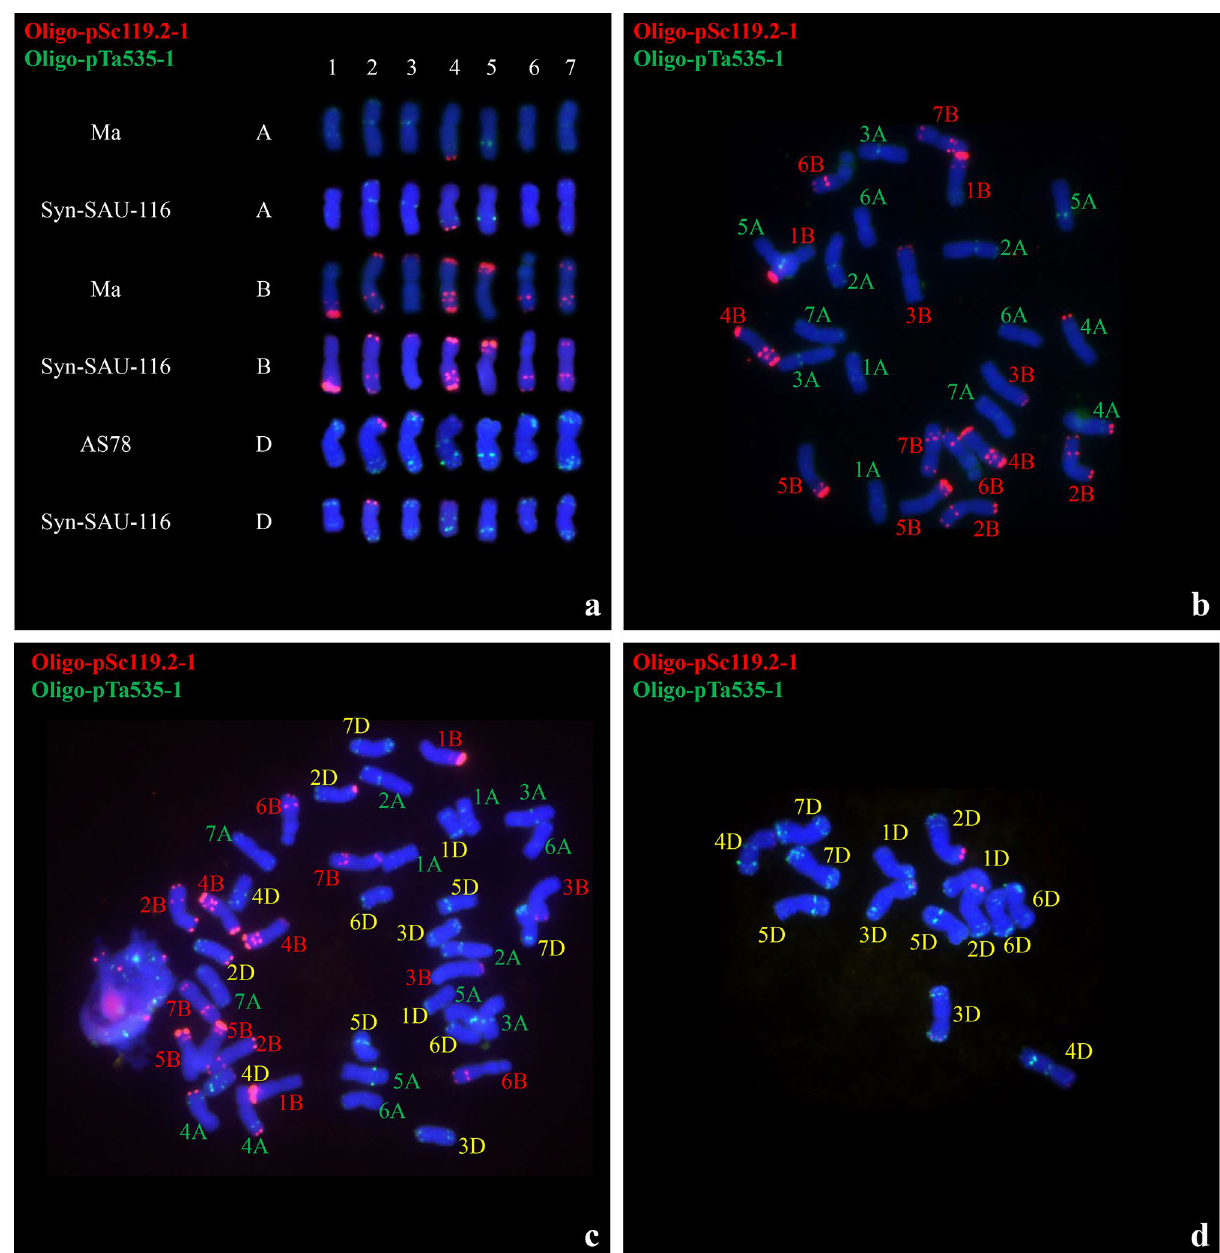
Figure 7. FISH identification of Syn-SAU-116 and its parent. ( a ): FISH karyotypes of the A, B, and D genomes in Syn-SAU-116 and its parents; ( b ): Ma; ( c ): Syn-SAU-116; ( d ): durum and Ae. tauschii , which is different from solid-stem wheat such as Xiaoyan 81, 86–741, XSXS, WYSG, etc. 12,13,53,54 . In this study, the expression of a solid second internode at the base of the stem was stable for two synthetic hexaploid wheat lines, Syn-SAU-117 and Syn-SAU-119, grown in both the greenhouse and field. The second internode at the base of the stem of Syn-SAU-117 was semisolid, while that of Syn-SAU-119 was solid in both the greenhouse and field. This difference may have been caused by the different male parents, which were all Ae. tauschii . There may be suppressor genes on the chromosomes of the D genome in Ae. tauschii AS92 to suppress the solid expression of stems in Syn-SAU-117, but this needs to be further studied. Previous studies have shown that crop lodging resistance is closely related to plant height, internode length, internode thickness, internode wall thickness, and internode fullness 12,17 . More vascular bundles, larger vascular bundle areas, and thicker mechanical tissue and parenchyma are all conducive to the improvement of lodging resistance 7,17 . In this study, all four synthetic wheat samples had large outer diameters, very small or no pith cavity, well-developed mechanical tissues, thick stalk walls and a large number of vascular bundles in the second internodes of the base. These lines showed strong lodging resistance, which was in agreement with the selec- tion characteristics of modern cereal crops for lodging resistance breeding 16 . The lodging resistance of the four